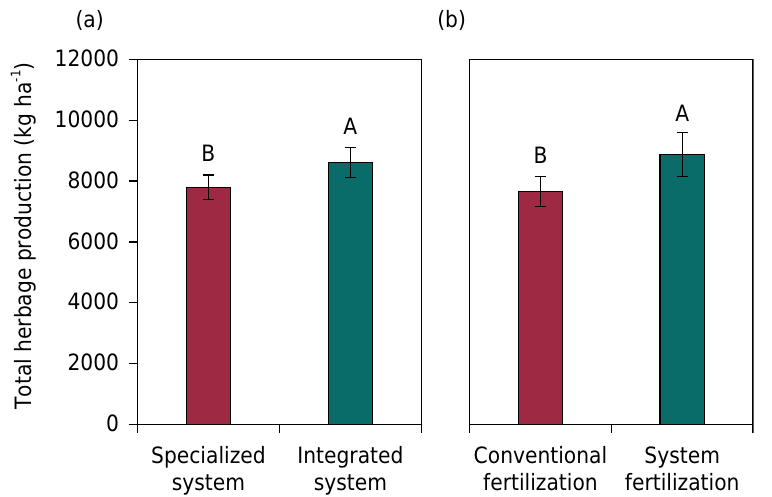
Figure 4. Total herbage production of Italian ryegrass (average of the years 2017, 2018 and 2019) as affected by animal grazing (specialized or integrated) (a) and fertilization strategy (conventional or system) (b). Different letters denote significant differences as per Tukey’s test (p<0.05).